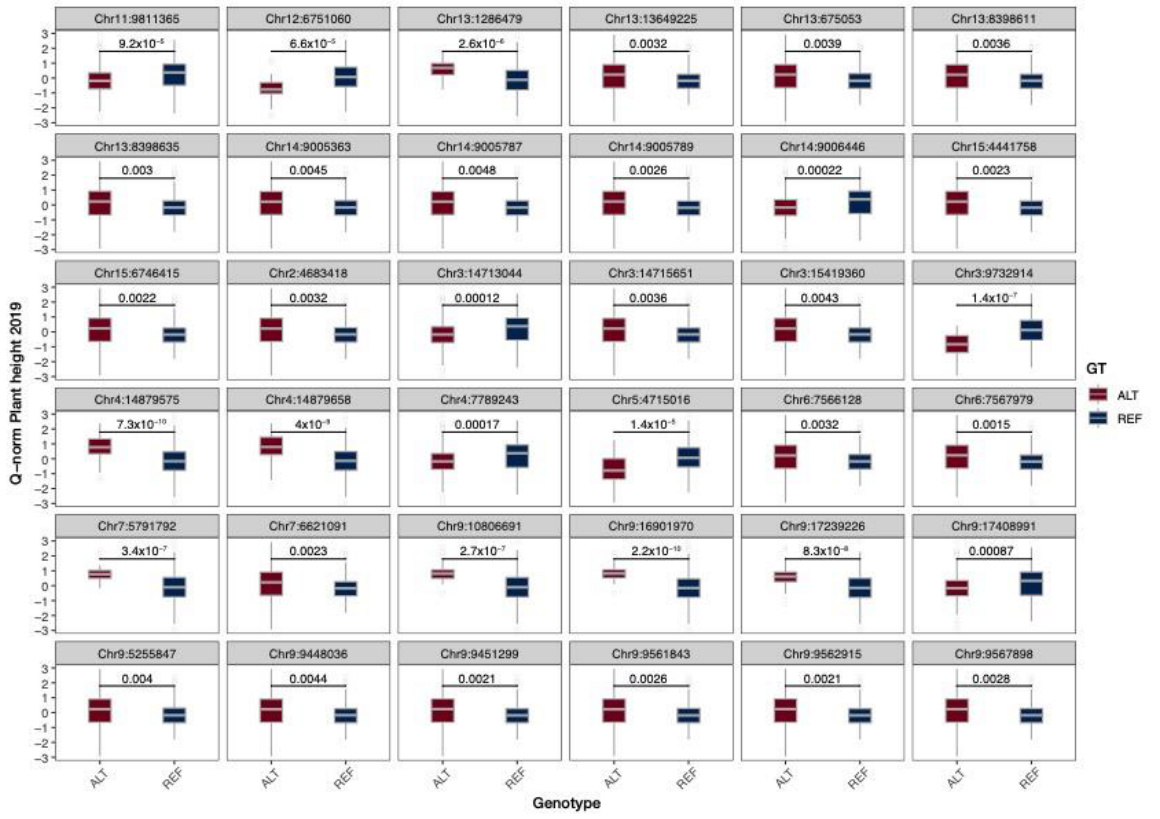
Figure 2. Box plots of allelic effects for representative QTNs associated with plant height in 2019. Numbers are p -values according to the Mann – Whitney – Wilcoxon non-parametric test .